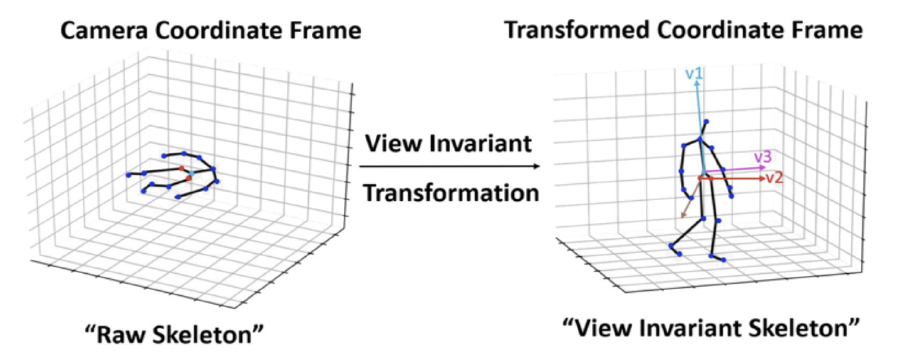
Figure 4. Preprocessing of body keypoints sequences according to view-invariant transformation